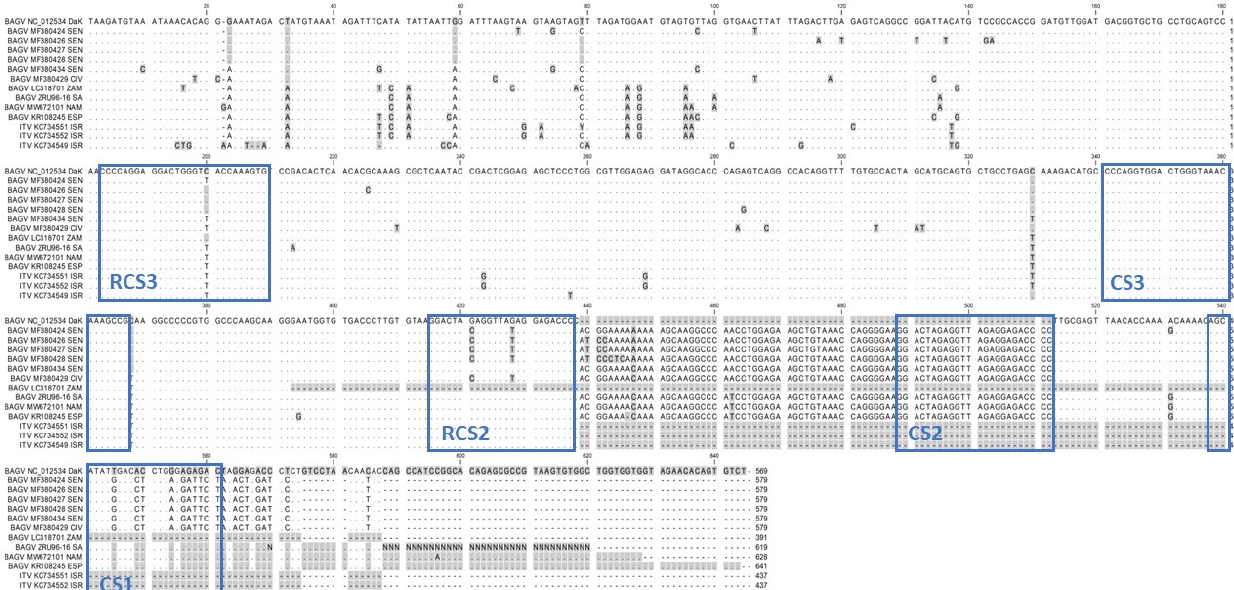
Figure 2. Multiple sequence alignment (MSA) of ITV and BAGV 3 ′ UTR nucleotide sequences. The 3 ′ UTR of ZRU96-16 was compared to a selection of BAGV and ITV 3 ′ UTR segments. The boxes highlighted in blue represent conserved sequence motifs or repeat motifs (R) (CS1-3) that have been identified in other flavivirus UTRs. The region prior to the RCS3 and downstream the stop codon (TAA) is considered to be a variable region in most flaviviruses.